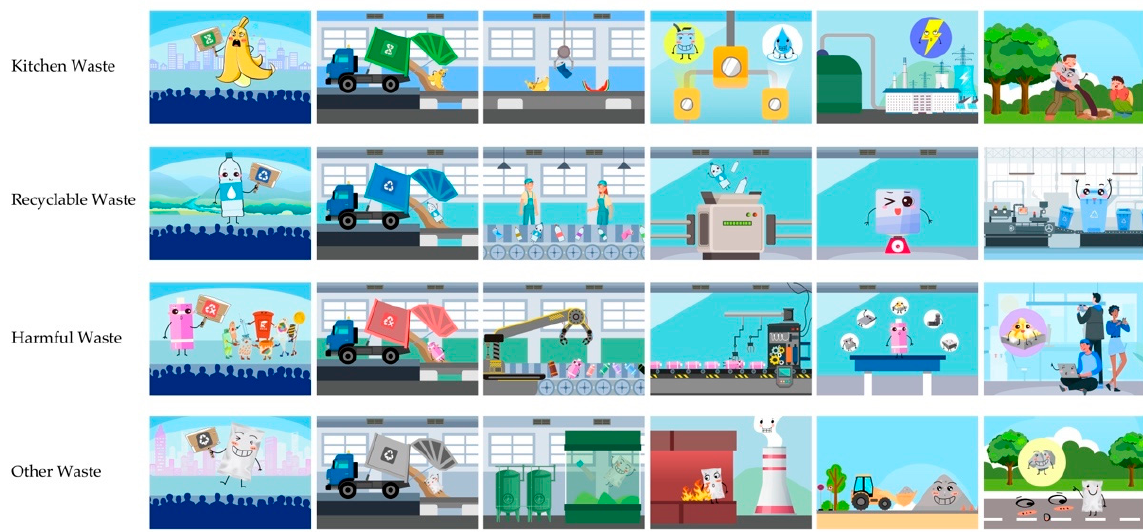
Figure 5. Key animation frames of the representative disposal of each type of waste.